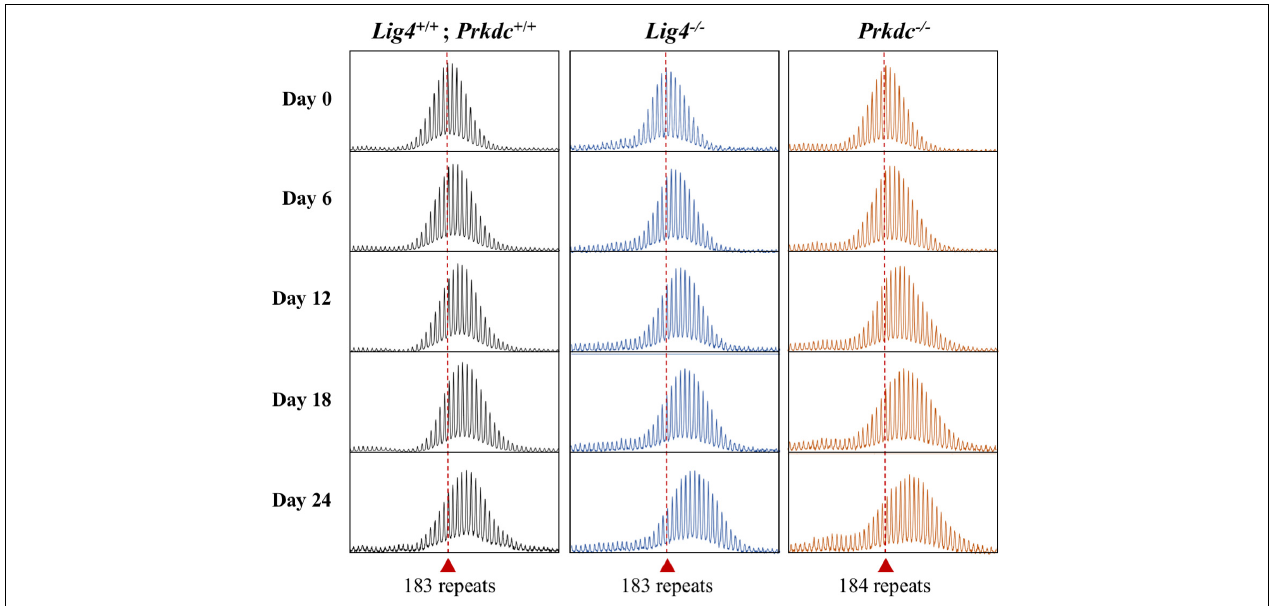
FIGURE 4 | Effect of the loss of NHEJ proteins on repeat expansion in mESCs. Representative repeat PCR profiles of Lig4 + / + ; Prkdc + / + , Lig4 − / − , and Prkdc − / − mESCs with 183–184 repeats that were grown in culture for the indicated times. Dashed lines represent the initial repeat size at day 0. At least 2 mESC lines were tested for each genotype with similar results being obtained for each line.